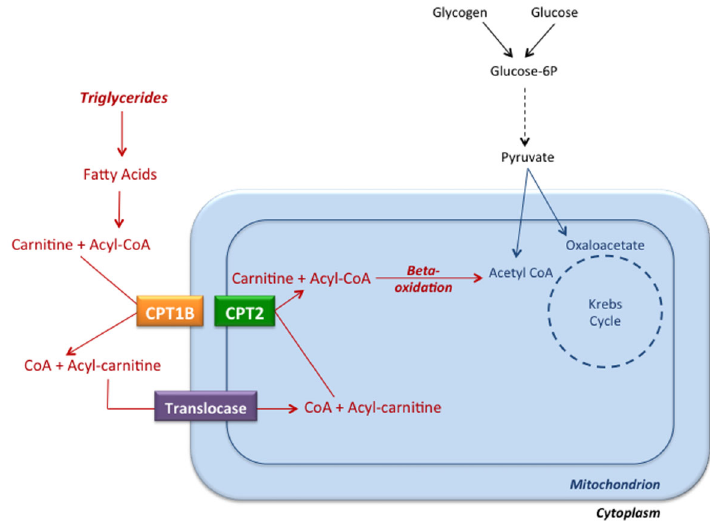
Figure 3. Entry of long-chain fatty acids into mitochondria and fatty acid beta-oxidation. Initially, triglycerides are hydrolyzed into fatty acids and glycerol. Long-chain fatty acid chains are first linked to coenzyme A (CoA), and then fatty acids are transferred to carnitine by the catalytic activity of the enzyme carnitine palmi- toyltransferase 1B (CPT1B), which is anchored in the outer mitochondrial membrane. The complex of a fatty acid and carnitine (Acyl-carnitine) is transported across the mitochondrial membranes by a translocase, and the enzyme carnitine palmitoyltransferase 2 (CPT2), associated with the inner surface of the inner mitochondrial membrane, catalyzes the conversion of Acyl- carnitine complexes into carnitine and Acyl-CoA. Acyl-CoA molecules are beta-oxidized by mito- chondrial enzymes, generating Acetyl-CoA, which enters the Krebs’